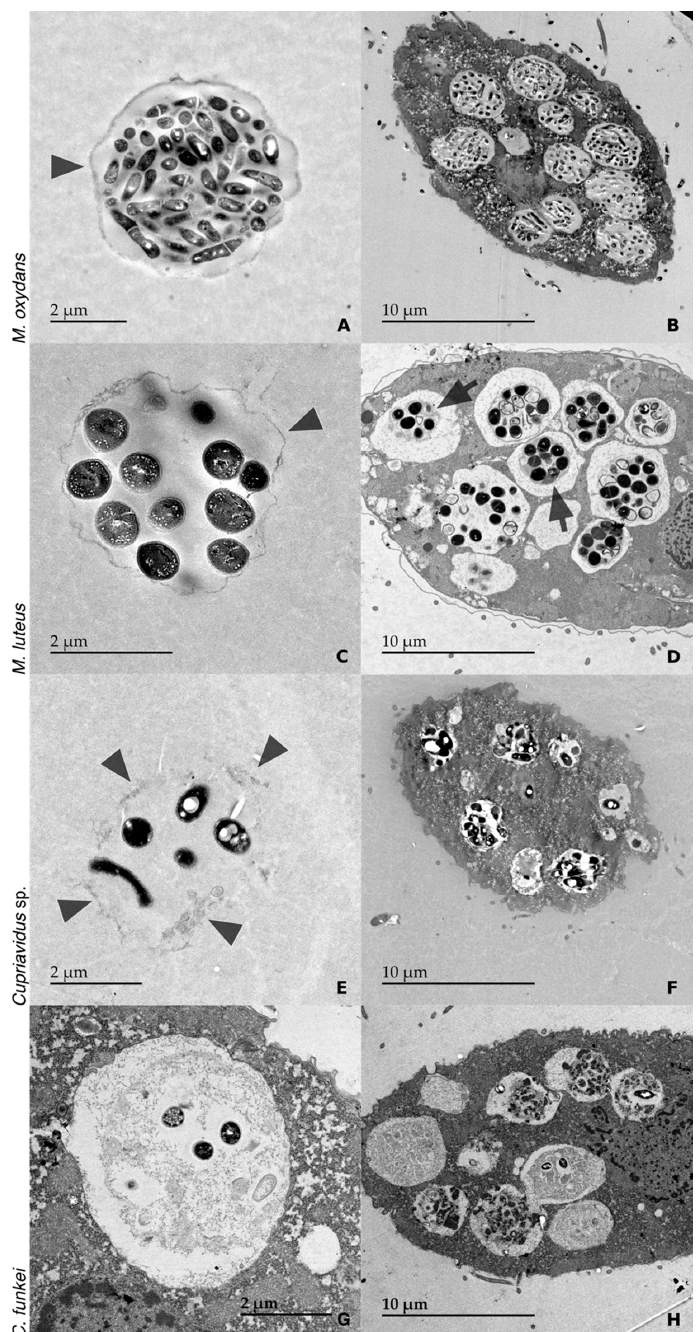
Figure 2. TEM images of bacteria packaging by Tetrahymena . Pellets produced in a co-culture of T. pyriformis and M. oxydans ( A ), T. thermophila and M. luteus ( C ), T. thermophila and Cupriavidus sp. ( E ), and T. pyriformis and C. funkei ( G ). In the case of C. funkei , since no expelled pellet was observed, a pellet in a late food vacuole prior exocytosis is shown. T. pyriformis containing M. oxydans ( B ), T. thermophila containing M. luteus ( D ), T. thermophila containing Cupriavidus sp. ( F ), and T. pyriformis containing C. funkei ( H ) are also shown. Co-cultures were performed for 4 h in all cases, except for M. luteus , where the co-culture lasted 16 h. Arrowheads point to the outer layer around the pellets when it is present. Multiple arrowheads are used when the layer is not continuous. Arrows point to thicker layers observed around the pellets in formation. Magnification: A, 2500×; C, 4000×; E and G, 3000×. Pictures B, D, F, and H were taken at 1000× magnification.